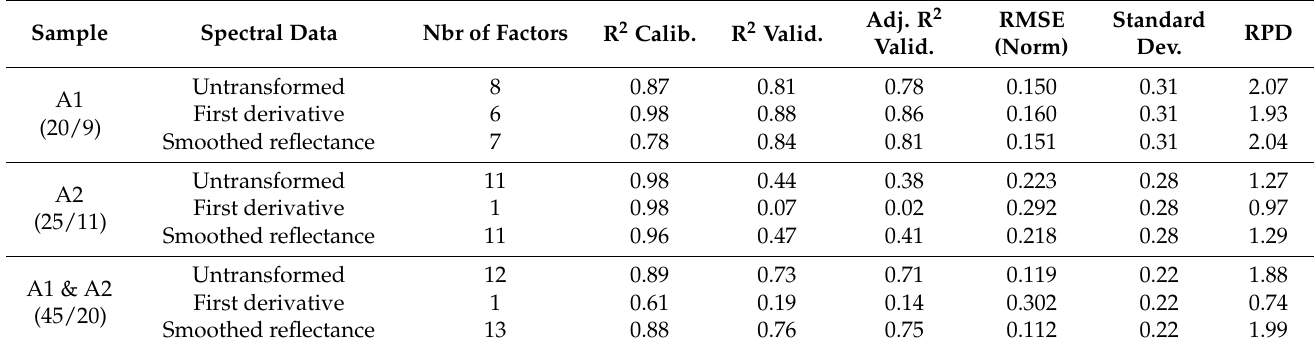
Table 4. Validation results for the PLSR models for estimating SOC using the 350–2500 nm